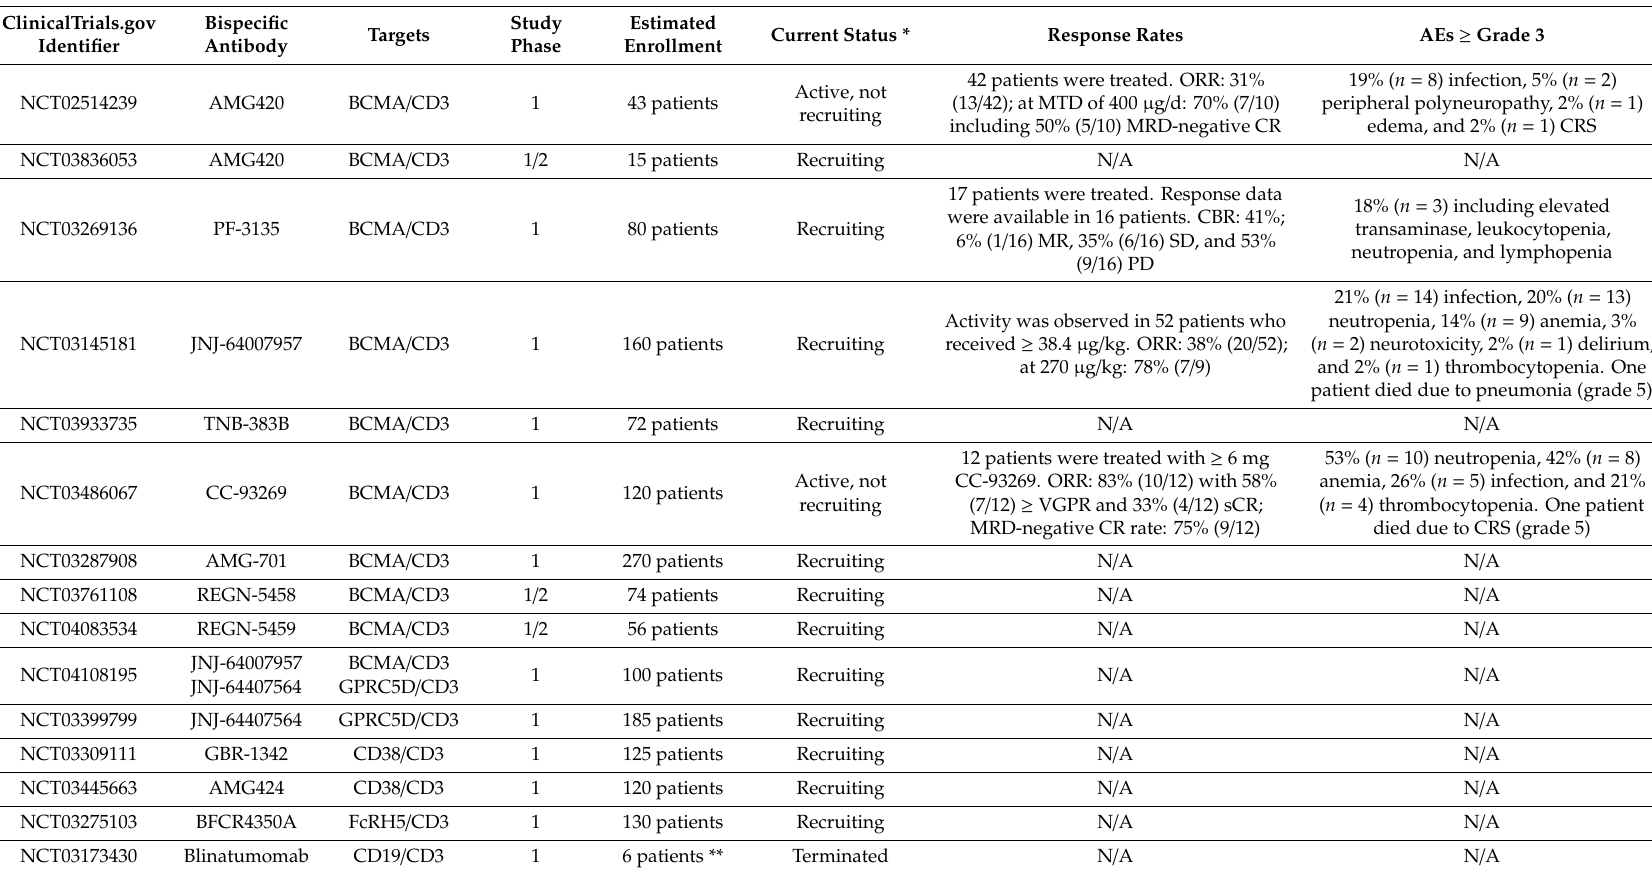
Table 1. Overview of clinical trials investigating bispecific antibodies (bsAbs) in multiple